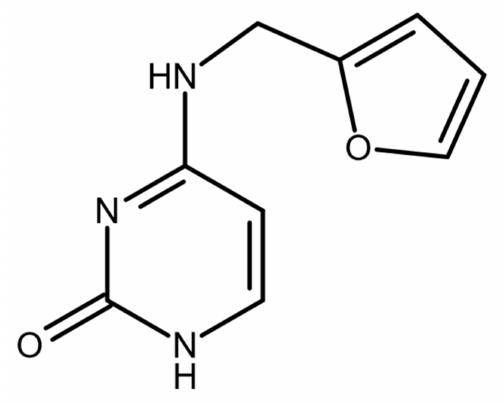
Figure 1. Chemical structure of